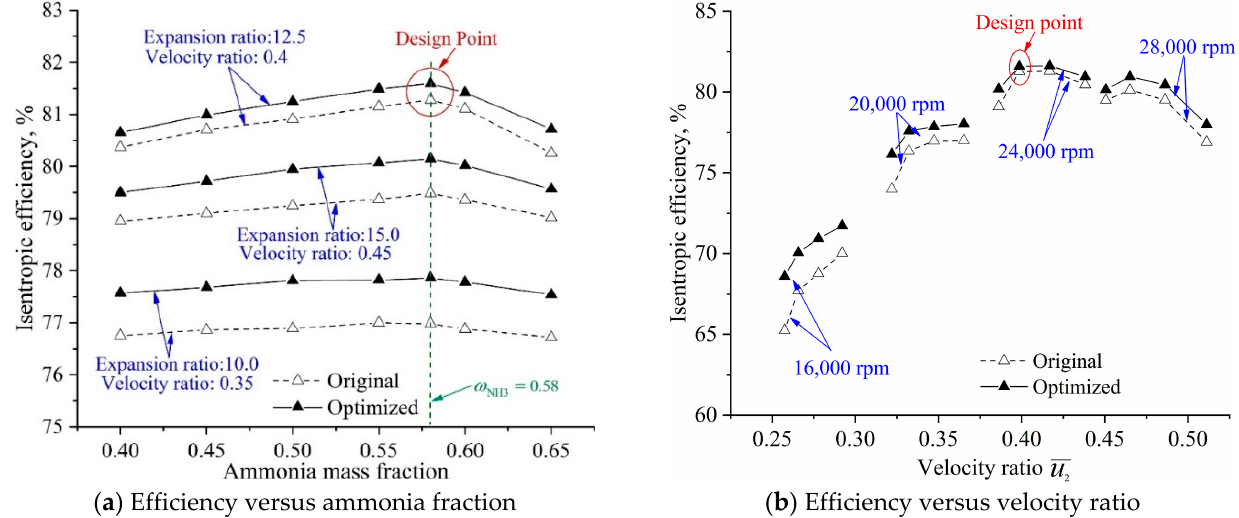
Figure 16. Original and optimized turbine efficiency curves.